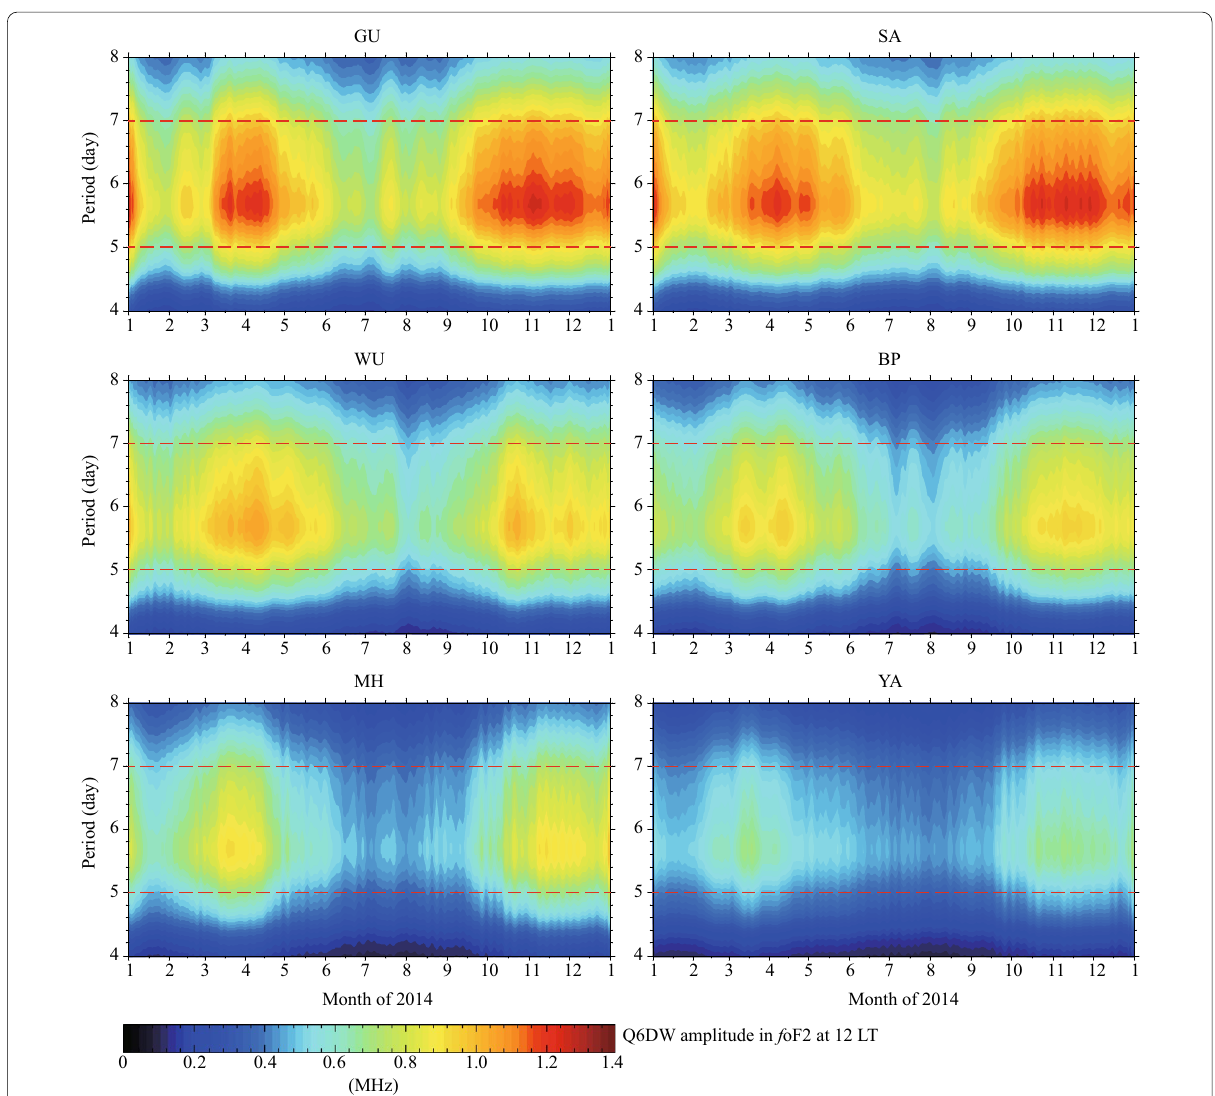
Fig. 5 The time variations of the f oF 2 spectrum at 12:00 LT during 2014 at Guam (GU), Sanya (SA), Wuhan (WU), Beijing (BP), Mohe (MH) and Yakusk (YA). Dashed red lines represent the period of 5 and 7 days,